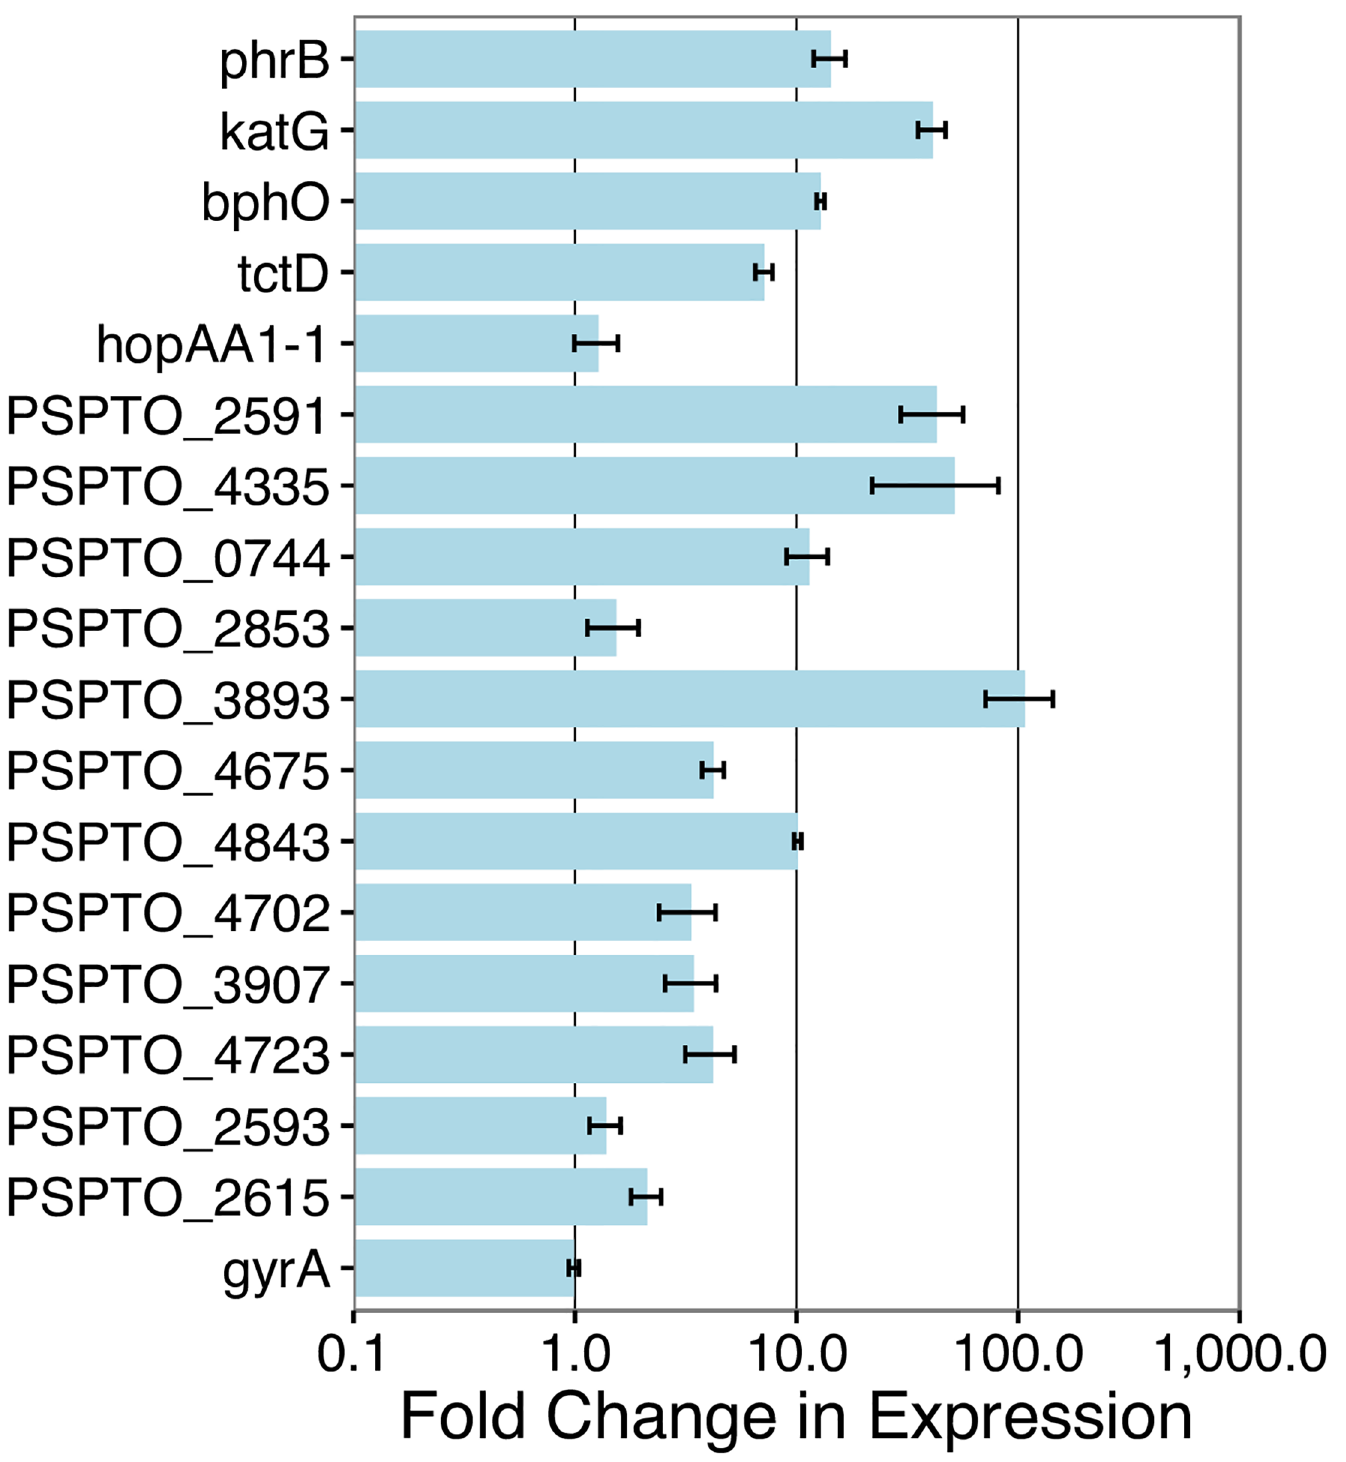
Fig 2. PSPTO_1043-dependent expression in DC3000. Seventeenputative PSPTO_1043-controlled genesand one housekeeping gene ( gyrA ) were evaluatedand the fold changein expressionbetweenstrains overexpressing PSPTO_1043 and those carrying the empty vector was calculatedas describedin the methods (normalized to the housekeeping gene gap-1 ).